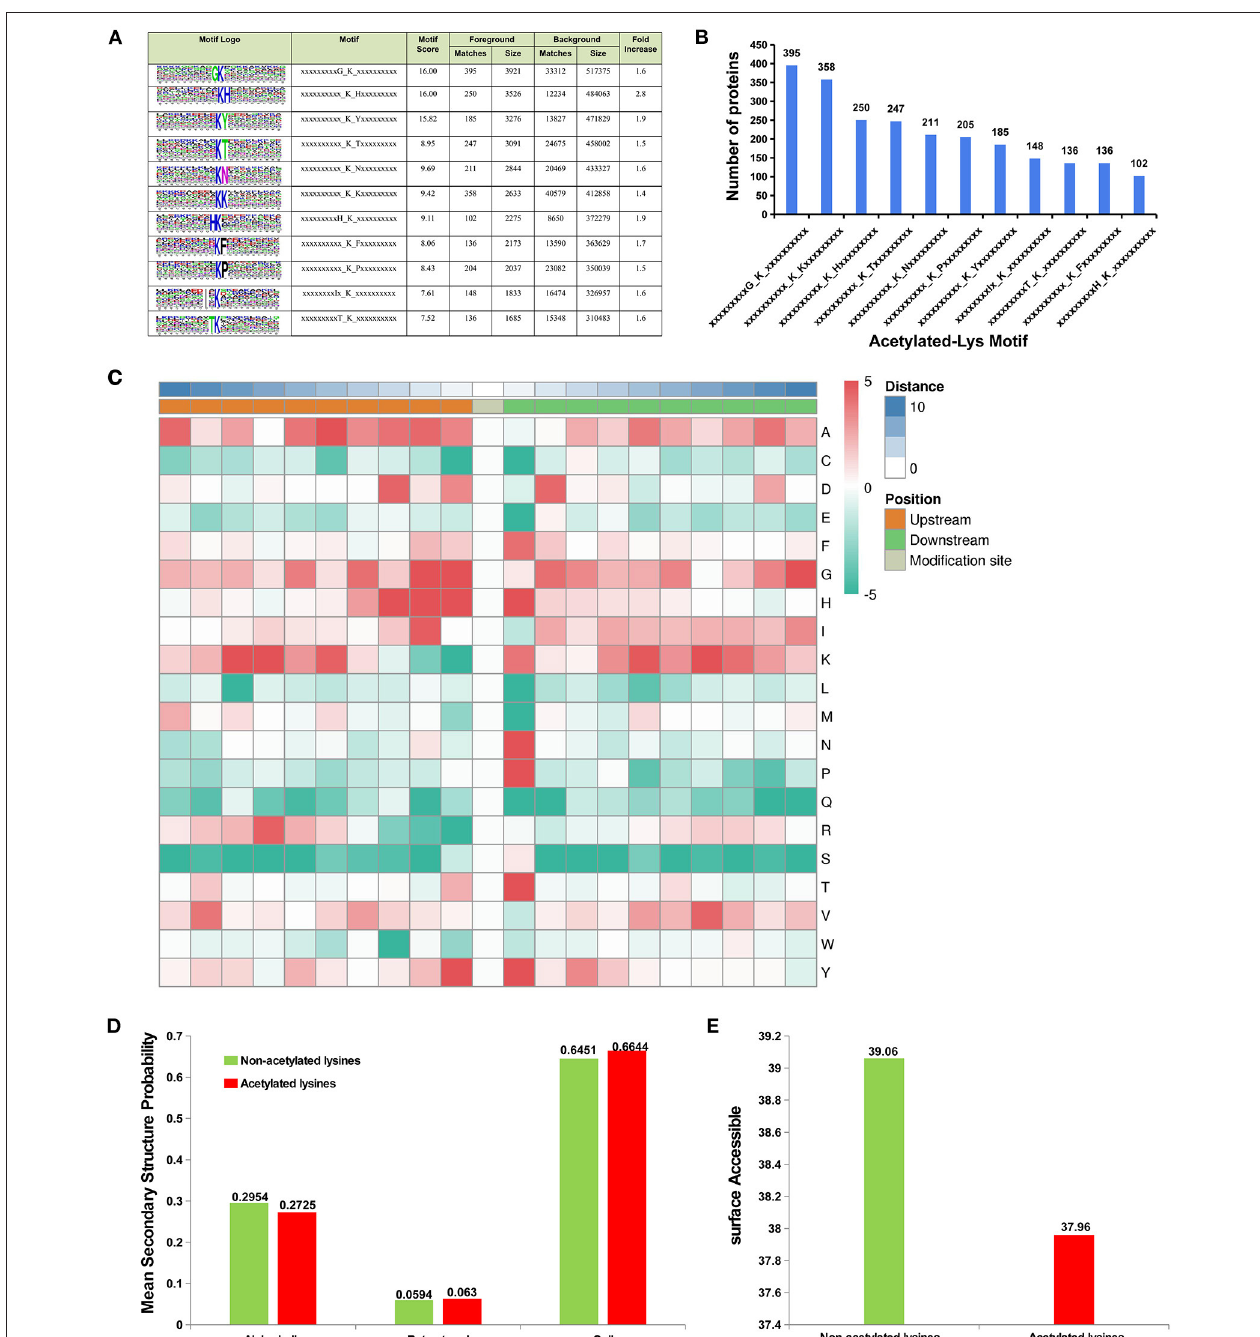
FIGURE 5 | Sequence preference of lysine acetylation sites. (A) Probable sequence motifs of acetylation sites in liver tissue identified using Motif-X. (B) Number of identified peptides containing acetylated lysines and their probable motifs. (C) Heat map showing the relative frequencies of amino acids in specific positions, including enrichment (red) or depletion (green) of amino acids flanking the acetylated lysine in liver proteins. Location probabilities of acetylated and/or non-acetylated lysines in (D) protein secondary structures (alpha-helix, beta-strand, and coil) and (E) surface accessibility.